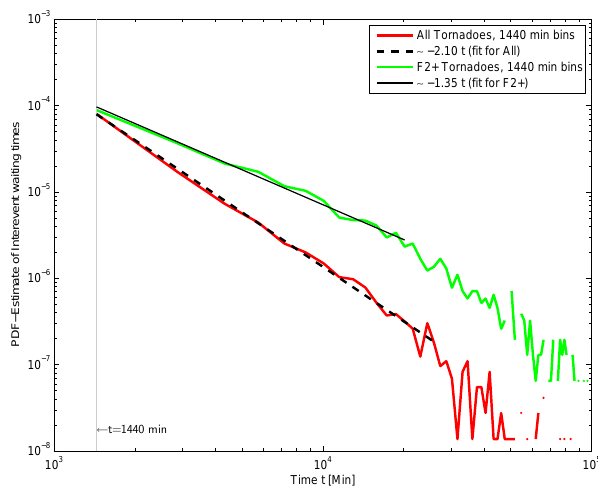
Fig. 3b. Long time analysis of interevent waiting times for all tor- nadoes (1950–2006, USA, red curve) and for tornadoes with Fu- jita intensities larger than or equal to F 2 ( F 2+ tornadoes, 1950– 2006, USA, green curve), based on 1440min bins. Linear fits have been applied to the double-logarithmic plotted data in the range of 1 day (1440min) to about 14 days (about 20000min) with slopes of − 2 . 10 for all tornadoes (black dashed line) and − 1 . 35 for F 2+ tor- nadoes (black solid line). The time line of 1440min (equal to 1 day) is highlighted by the grey vertical line in the plot.